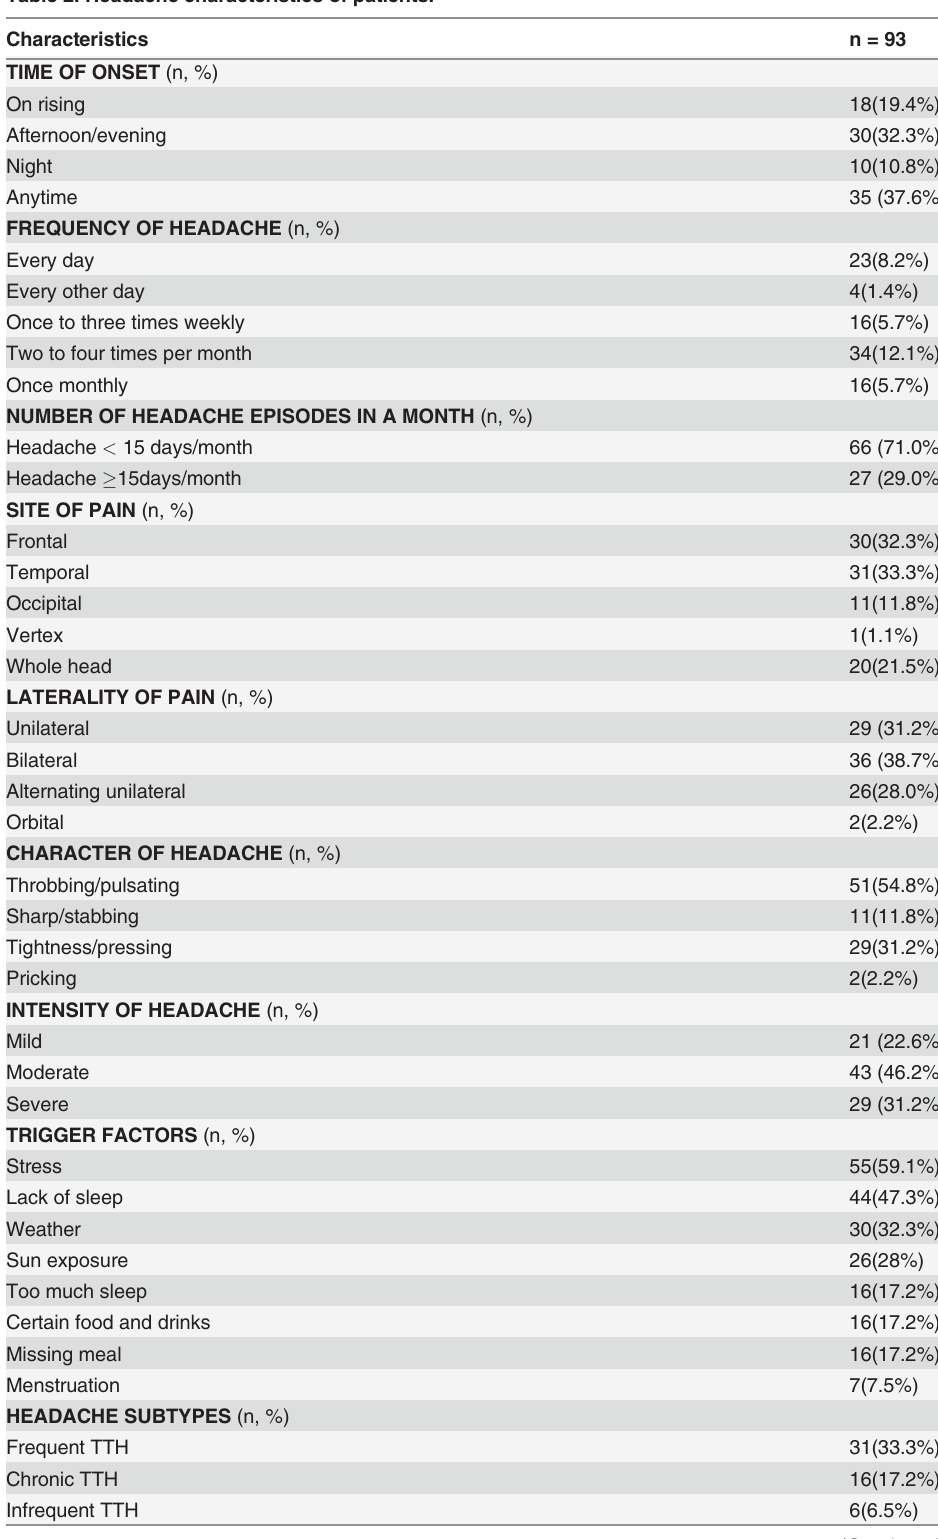
Table 2. Headache characteristics of